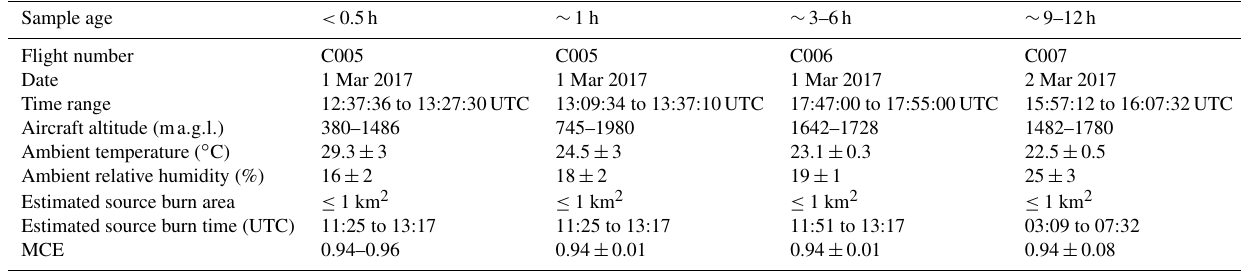
Table 1. The fundamental information and modified combustion efficiency (MCE) of sampled smoke plumes. Sample age <